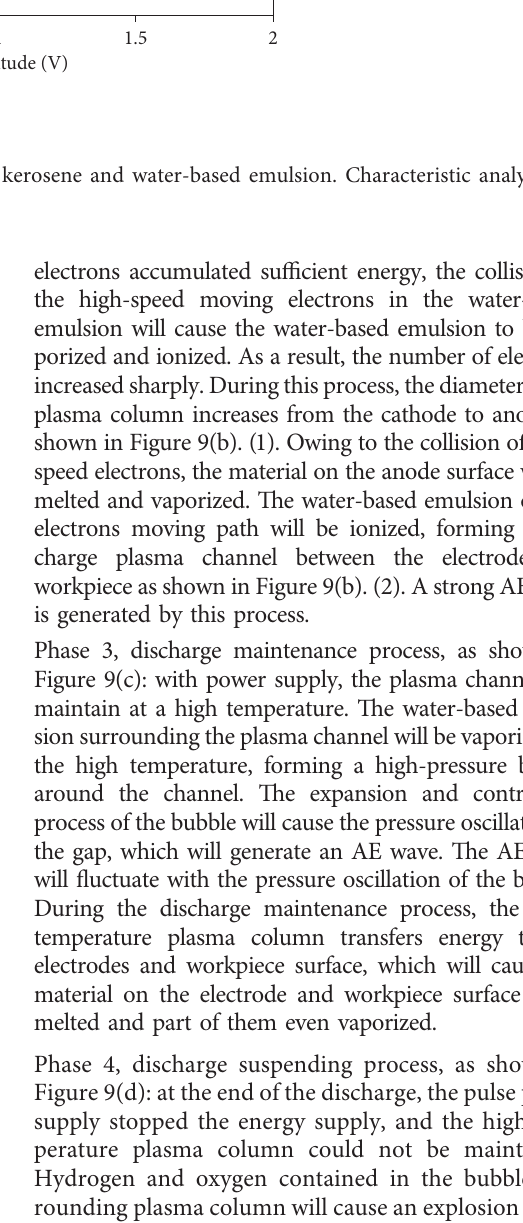
Figure 9(b): when the interelectrode electric field